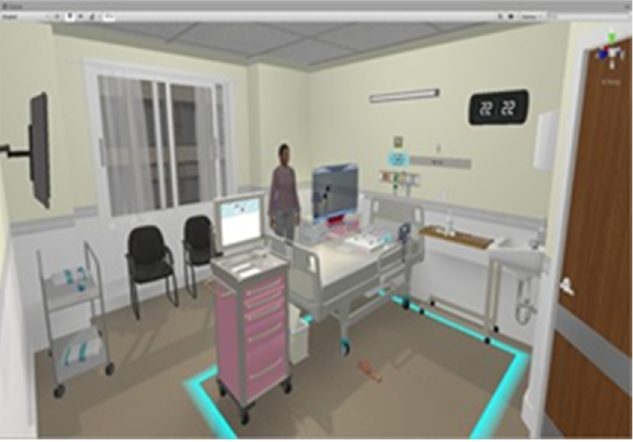
Figure 1. IVR simulation regarding how to place Foley catheters in female patients.